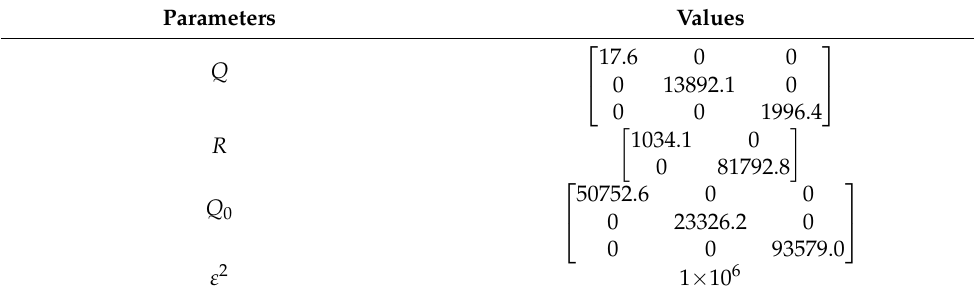
Figure 15. Tractor speed and deviation. The controller parameters after IQGA optimization are shown in Table 5. Table 5. The parameters of the dual shift trajectory controller are shown. Parameters